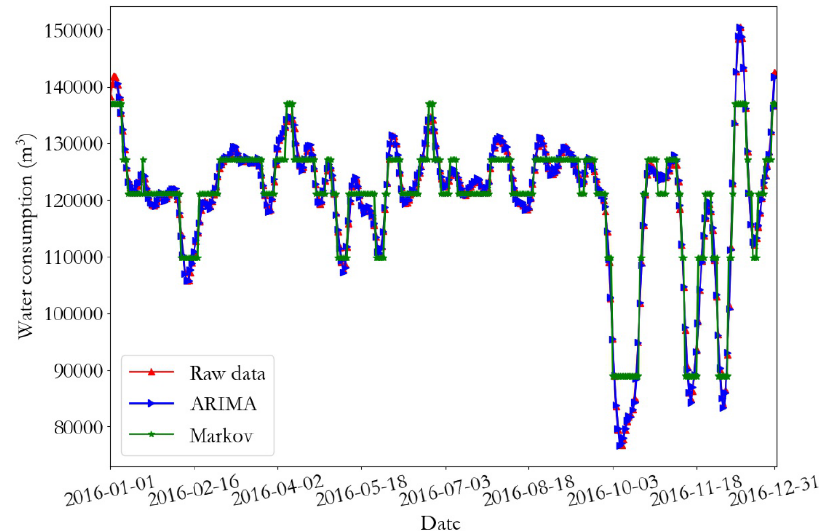
Figure 12. Prediction results from the training data at monitoring point 1.